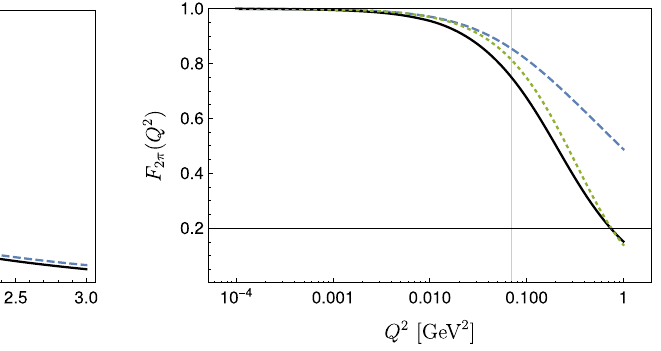
Fig. 1 Left panel: the pion e.m. form factor evaluated within the lat- tice framework, see Eq. (22). Full black line for the configuration A and dashed blue line for the configuration B . Right panel: comparison